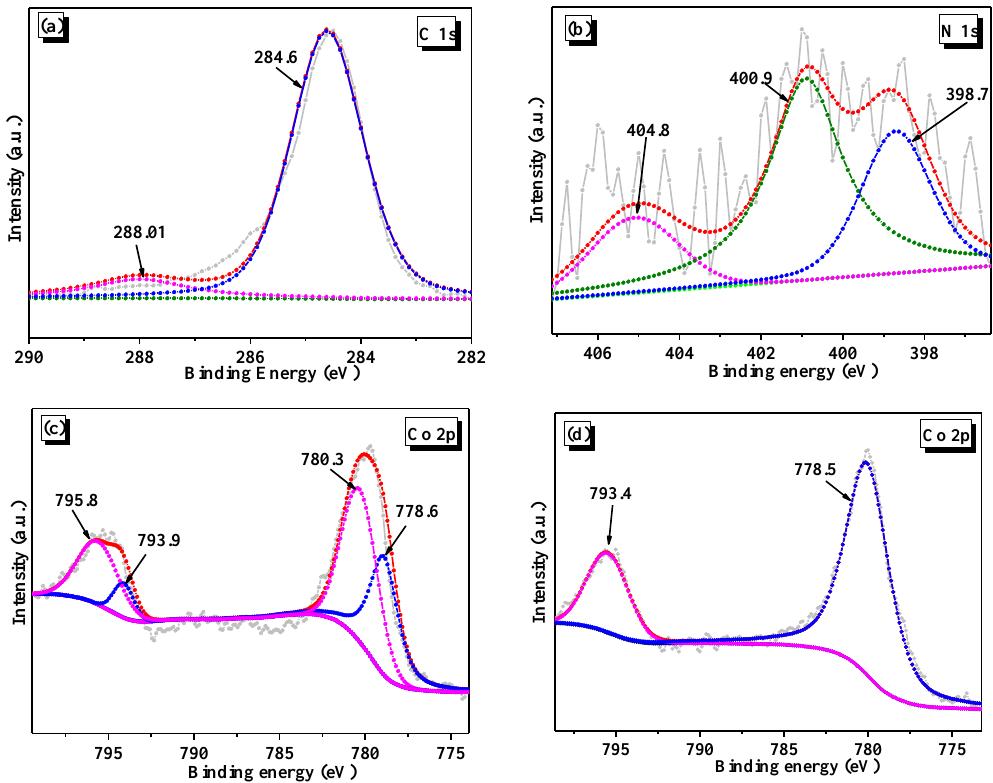
Figure 3. X-ray photoelectron spectroscopy (XPS) spectra for ( a ) C 1s, ( b ) N 1s, ( c ) Co 2p of CoO x –NDCNTs and ( d ) Co 2p of Co–NDCNTs